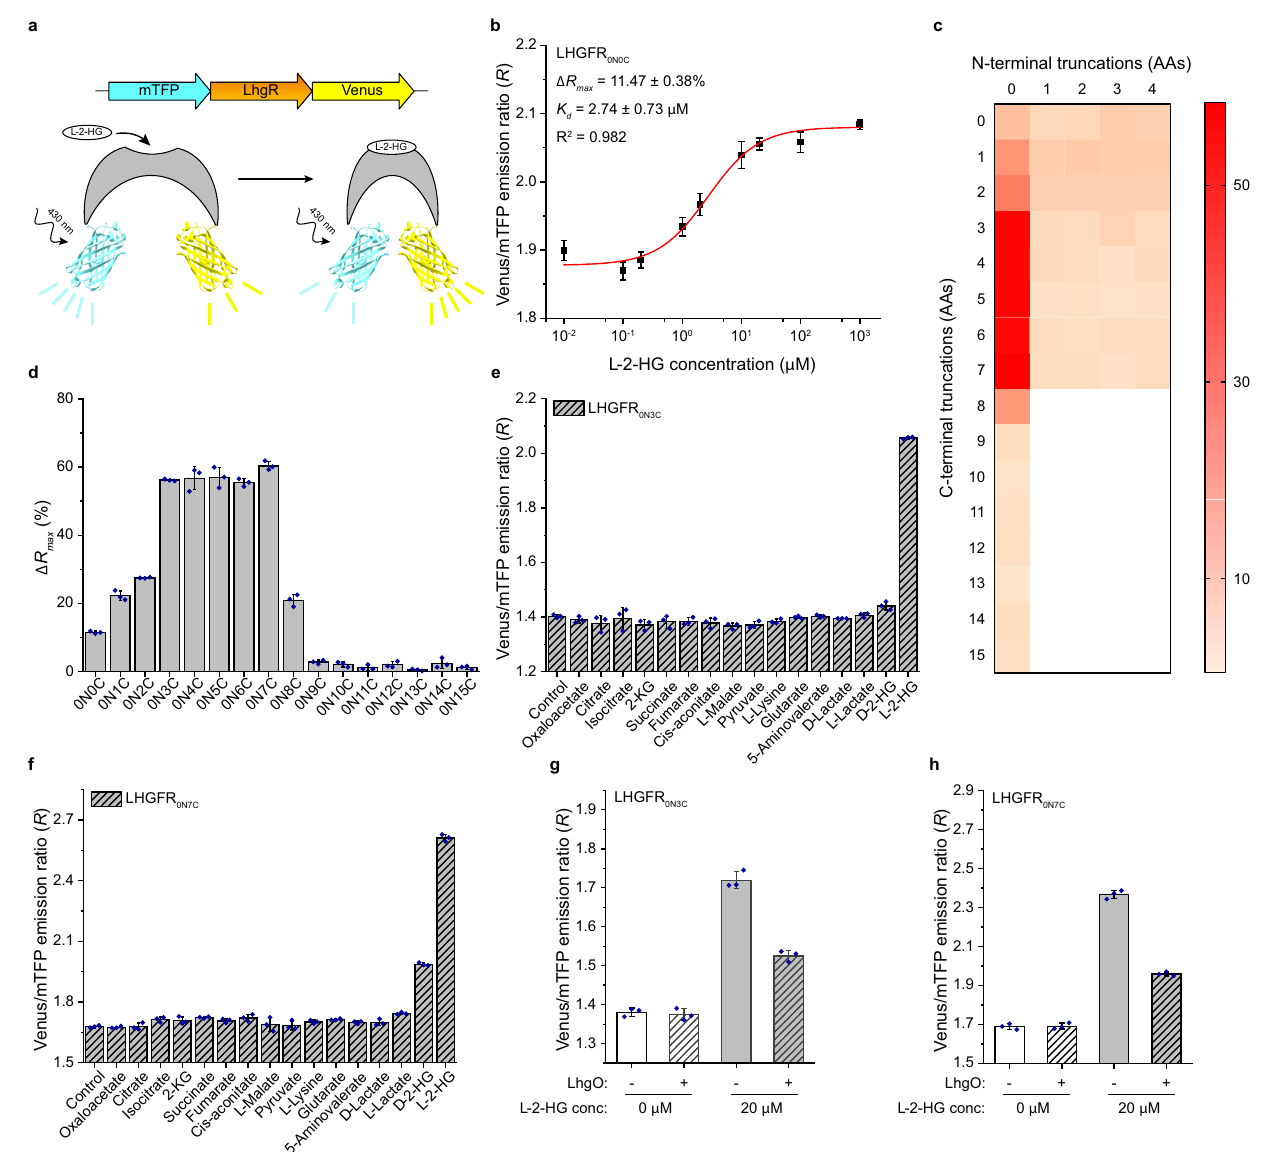
Fig. 3 Design and optimization of the LHGFR. a Schematic representation of the predicted conformational change of LhgR-based L -2-HG biosensor LHGFR in the absence or presence of L -2-HG. In particular, schematic representations of the tertiary structure of Venus and mTFP shown were predicted based on the respective protein sequences. b Dose-response curve of puri fi ed LHGFR 0N0C for increasing concentrations (10 nM to 1 mM) of L -2-HG in 50 mM Tris- HCl buffer (pH 7.4). The emission ratio of Venus to mTFP increased (430 nm excitation) after L -2-HG binding. c Heap map of the truncating the N-terminal and C-terminal amino acids of LhgR to Δ R max . The color indicates the value of Δ R max and white indicates the untested variants. d Comparison of the Δ R max of a set of L -2-HG biosensor variants based on the C-terminal amino acid truncated of LhgR. e , f Speci fi cities of the puri fi ed LHGFR 0N3C ( e ) and LHGFR 0N7C ( f ). The emission ratio changes of both biosensors were measured in the presence of 240 μ M D -lactate, L -lactate, L -2-HG, D -2-HG, or different intermediates of the TCA cycle and L -lysine catabolism. g , h Reversal of L -2-HG binding with LHGFR by conversion of L -2-HG to 2-KG. The emission ratio of puri fi ed LHGFR 0N3C ( g ) and LHGFR 0N7C ( h ) was recorded in the absence and presence of 20 μ M L -2-HG before and after the addition of 5 μ M puri fi ed LhgO for 25 min. All data shown are means± s.d. ( n = 3 independent experiments).